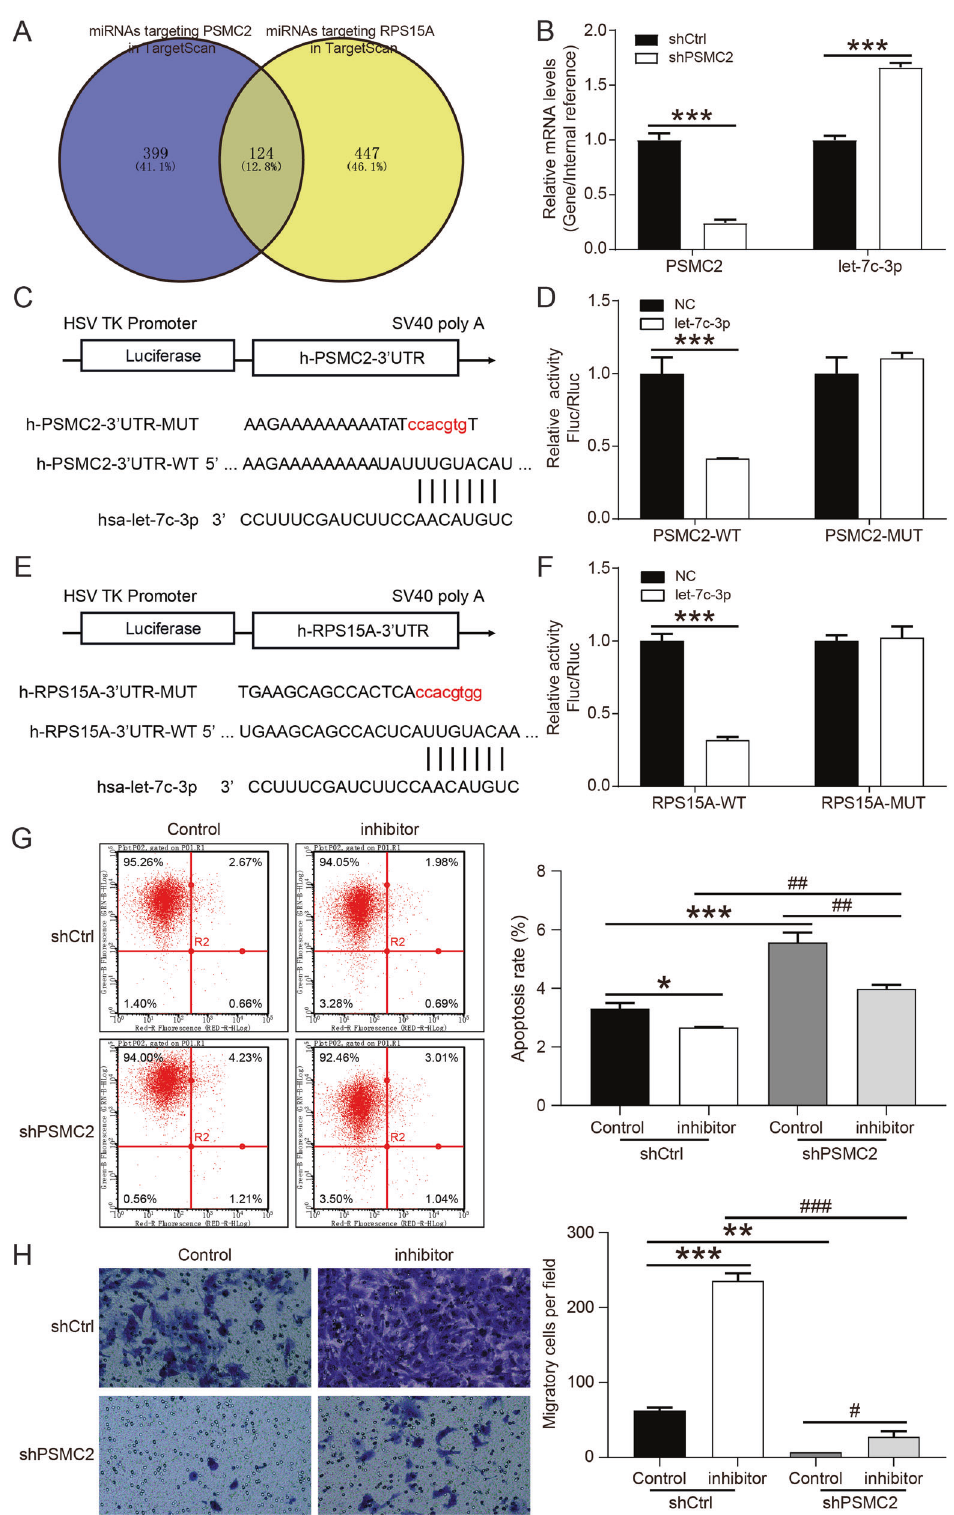
targeting both PSMC2 and RPS15A (Fig. 5A). Through the analysis of gastric cancer related data in TCGA database, tit was found that only 7 miRNAs were downregulated in gastric cancer, and 4 miRNAs with